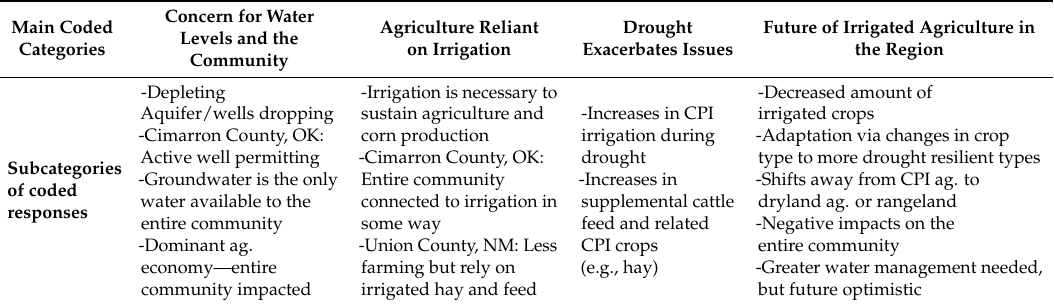
Table 3. Perceptions on CPI growth and vulnerability: coded categories from key informant interview responses on perceptions in Cimarron County, OK and Union County, NM ( n =